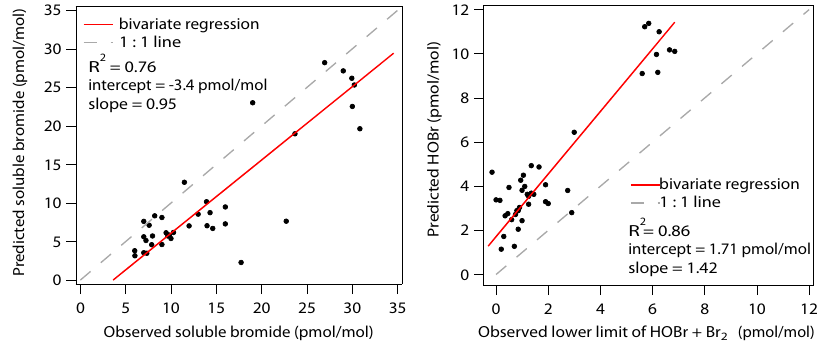
Fig. 4. Left panel: correlation plot of predicted and observed soluble bromide in the boundary layer when BrO was above the detection limit ( > 2pmolmol − 1 ) under unpolluted conditions (NO < 10pmolmol − 1 ). The correlation coefficient for this plot is 0.76. An equally weighted bivariate regression yields a slope of 0.95 and an intercept of − 3.4pmolmol − 1 . Right panel: correlation plot of predicted HOBr and observed lower limit of HOBr + Br 2 when BrO was above detection limit ( > 2pmolmol − 1 ) under unpolluted condition (NO < 10pmolmol − 1 ). The x-axis of the right panel is the lower limit of HOBr + Br 2 as only the fraction of HOBr converted to Br 2 in the inlet is observed by the CIMS. The correlation coefficient ( R 2 ) for this plot is 0.86. An equally weighted bivariate regression yields a slope of 1.42 and an intercept of 1.71pmolmol − 1 .